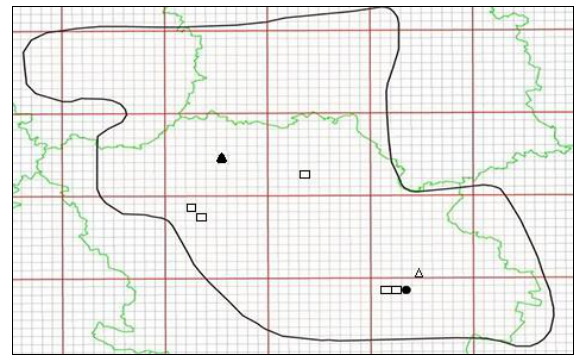
Fig. 2. The distribution of selected ephemerophytes in the Romensko-Poltavsky Geobotanical District: A. aestivalis L.;